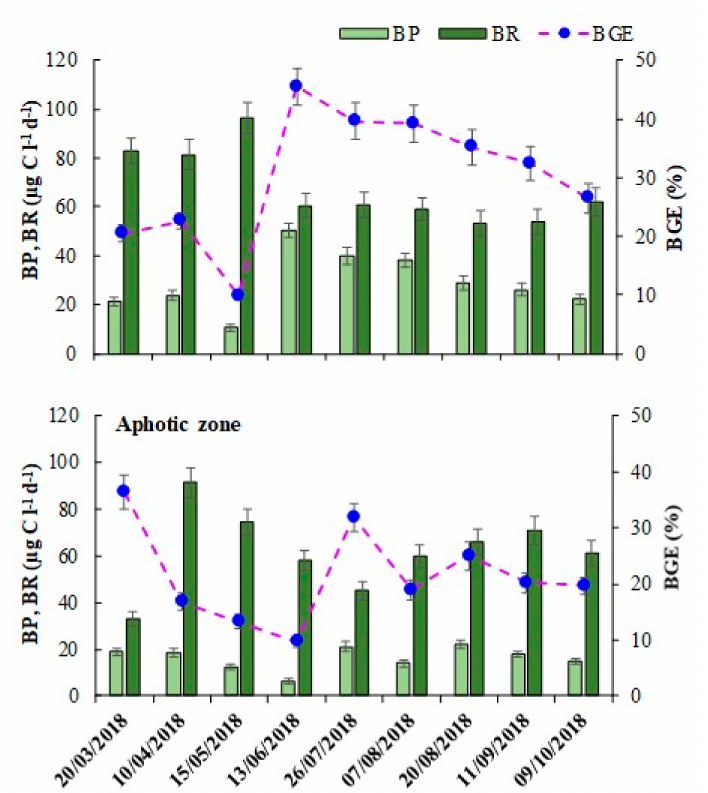
Figure 2. Time series variations in bacterial production (BP; light green bars), bacterial respiration (BR; dark green bars) and estimates of bacterial growth efficiency (BGE; blue dots; right y axis) at euphotic and aphotic zones in Lake Goule. Data represent mean ± SE ( n = 3).